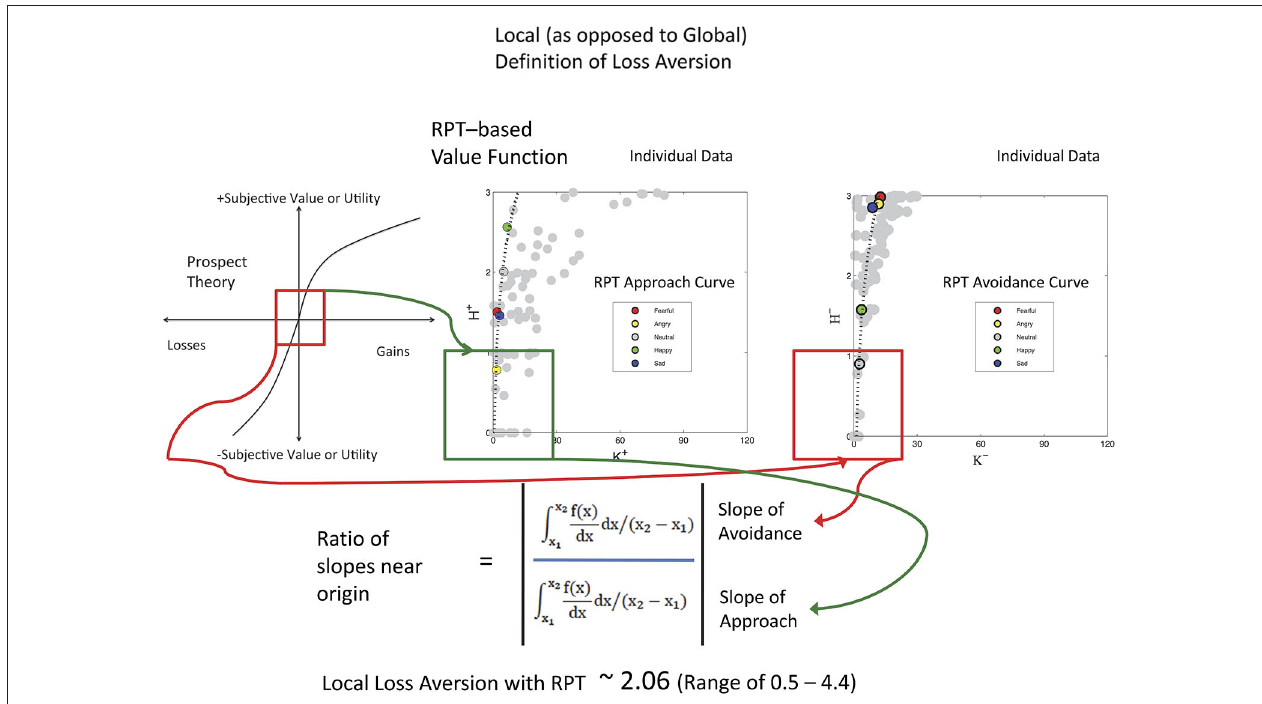
graphs (variables defined in Figure 3 legend) and avoidance KH graphs for the 17 subjects are shown as unfitted points in gray to the right. One example subject is shown with color points as defined in each graph with a fitted curve. The lowest 10% of these curves was then used for assessing the slopes as shown in the mathematics at bottom. Of interest, the LA value for these subjects approximates that reported by Tversky and Kahneman